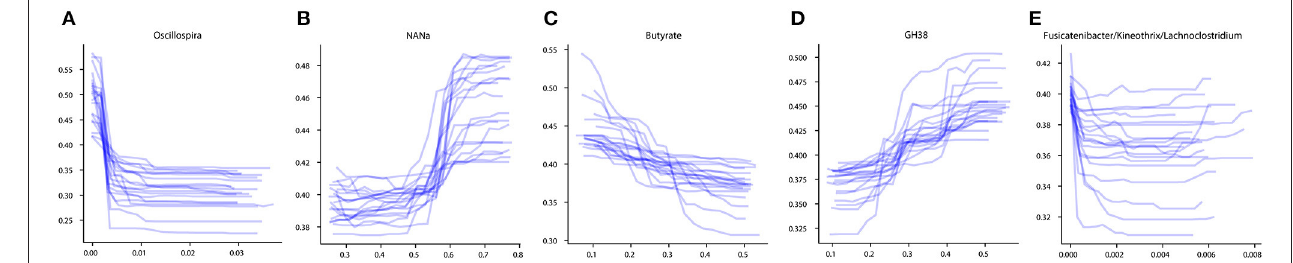
FIGURE 4 | Examples of different PDP forms. (A) Sharply decreasing PDP. (B) Sharply increasing PDP. (C) Smoothly decreasing PDP. (D) Smoothly increasing PDP. (E) Unclassified PDP. The x -axis of the plots denotes the taxonomic or phenotypic feature abundance, and the y -axis shows the probability of the CD classification outcome.